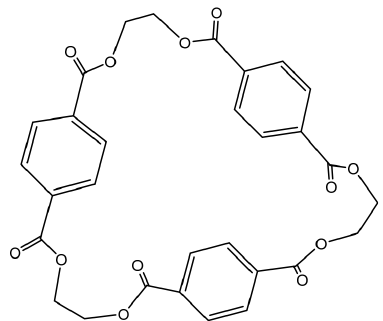
Figure 2. Molecular structure of cyclic